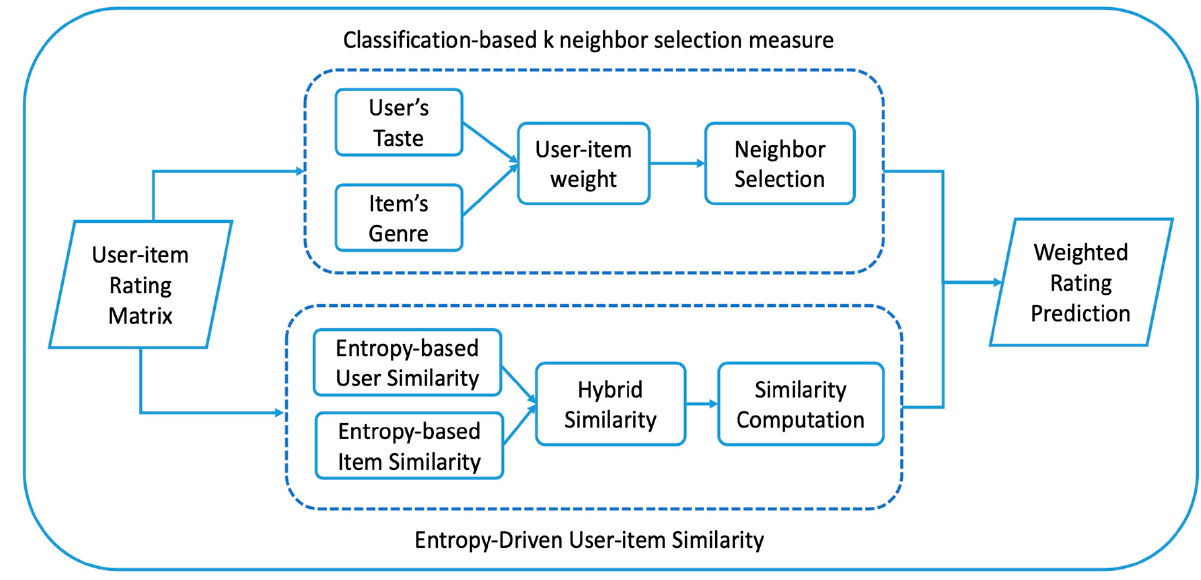
Figure 1. Flow diagram of the proposed model.